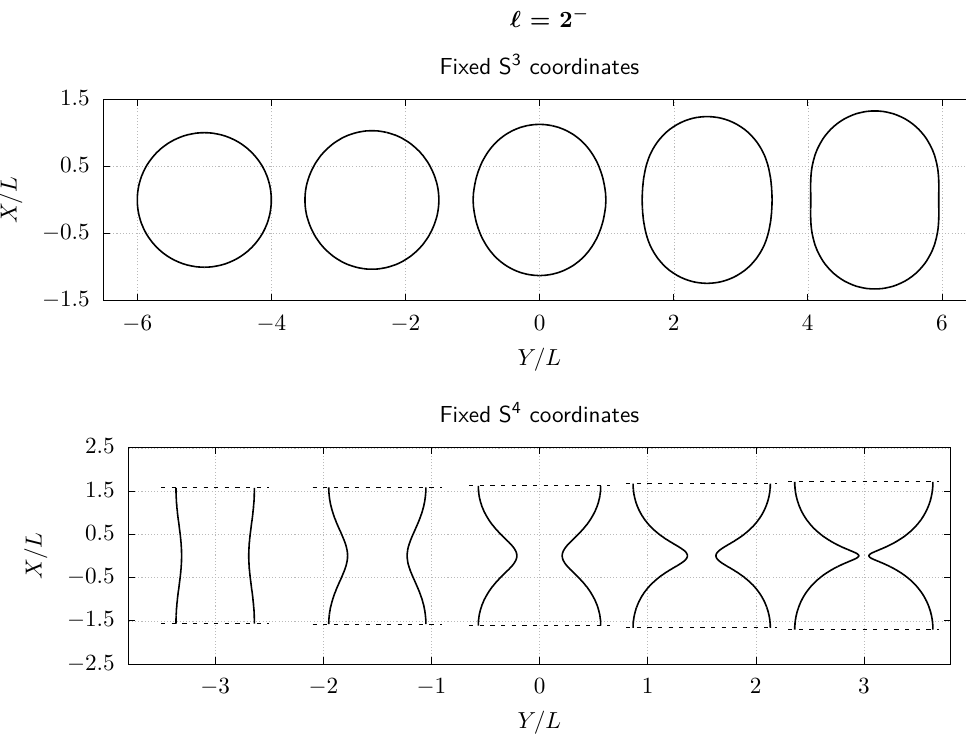
Figure 16. Embeddings plots for fixed S 3 /S 4 coordinates of lumpy black holes in AdS 5 × S 5 with ‘ = 1 , 2 + and 2 − . The corresponding plots for ‘ = 3 are similar to those for ‘ = 1 , but the pinch-off appears at the opposite